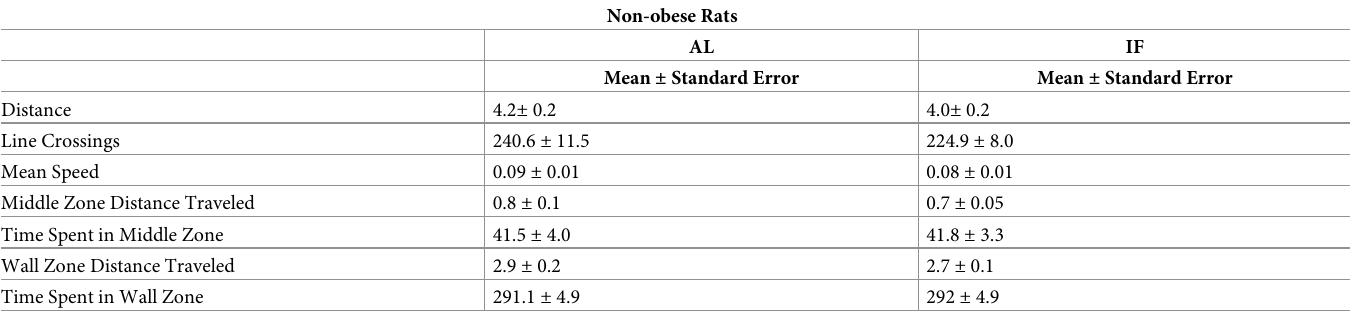
Table 5. Open field measurements in Non-obese control rats.